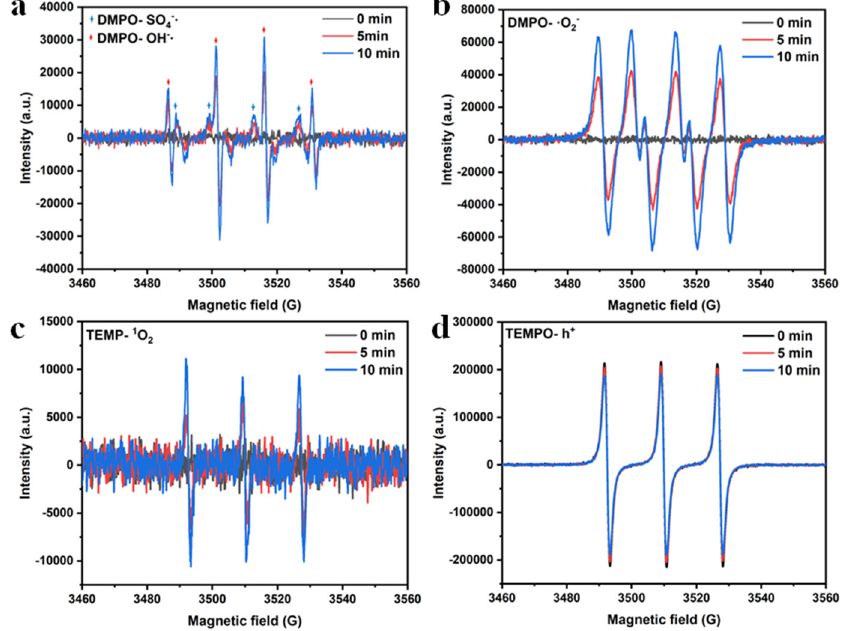
Figure 10. ESR analysis for the CMO-8/PDS system in aqueous dispersion by spin trapping with DMPO ( a ) SO4 − ·, OH·; ( b ) ·O 2 − ; ( c ) TEMP- 1 O 2 ; ( d ) TEMPO-h + at different time intervals.